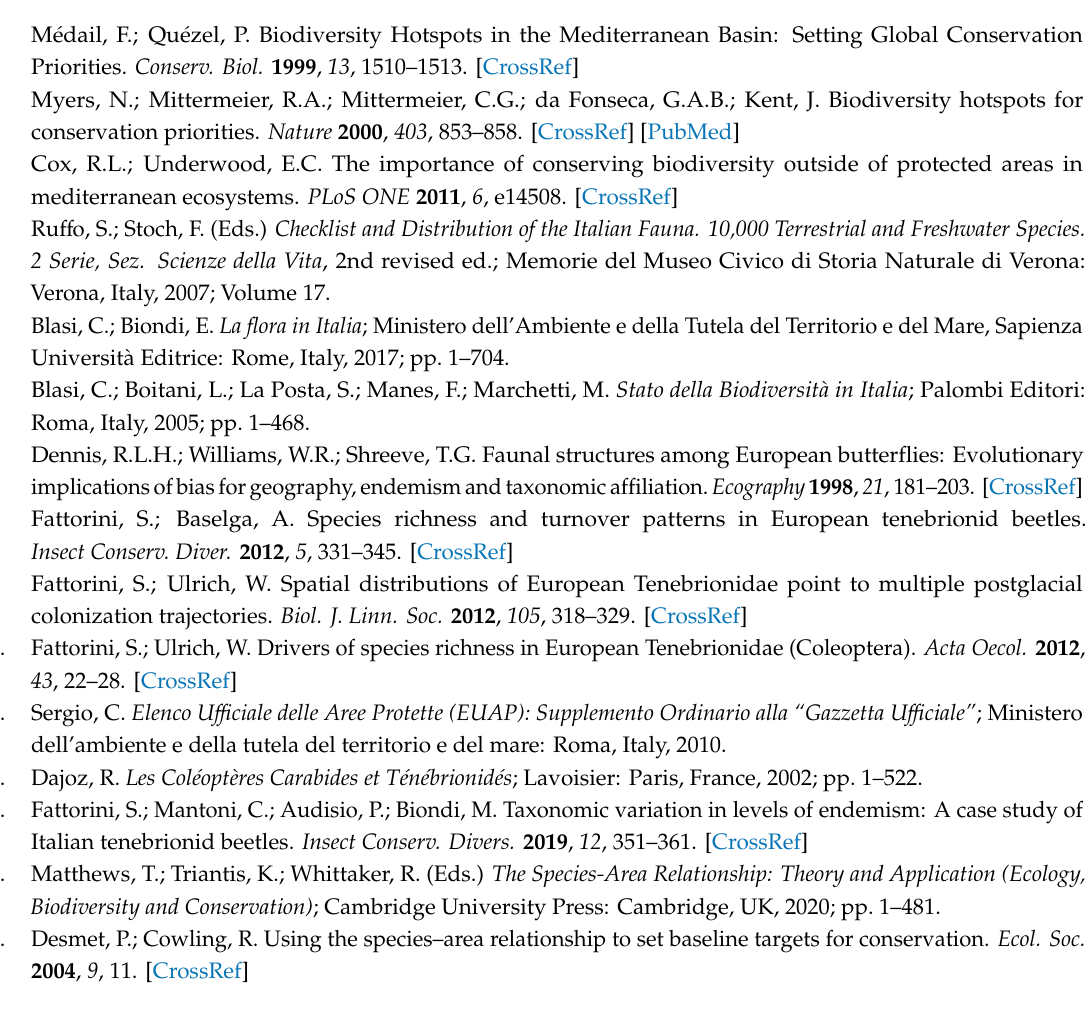
Table S1: Species distribution in Italian reserves. Species’ ecology (geophilous vs. xylophilous) and endemic status is also given. Reserve numbers, as in Figure